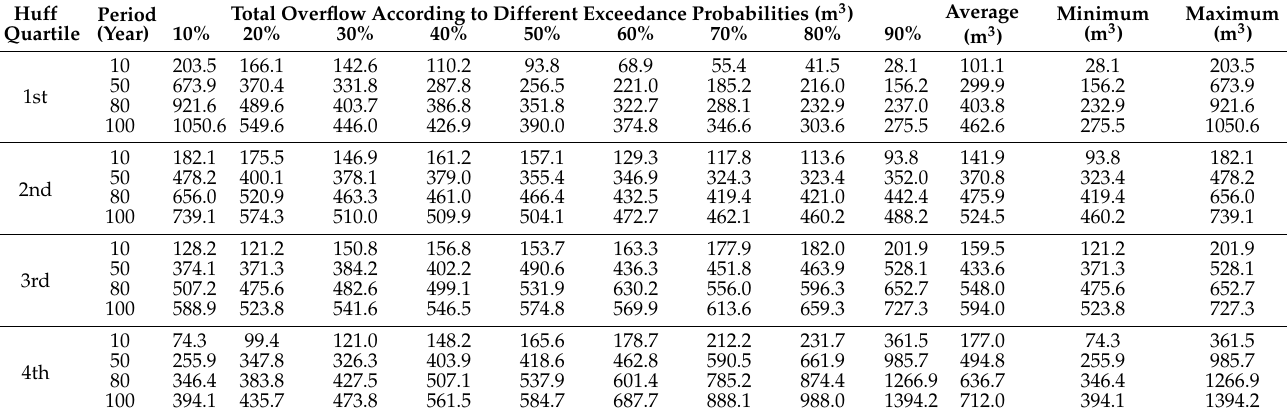
Table 3. The EPA-SWMM-model-simulated duration 2-h total overflow